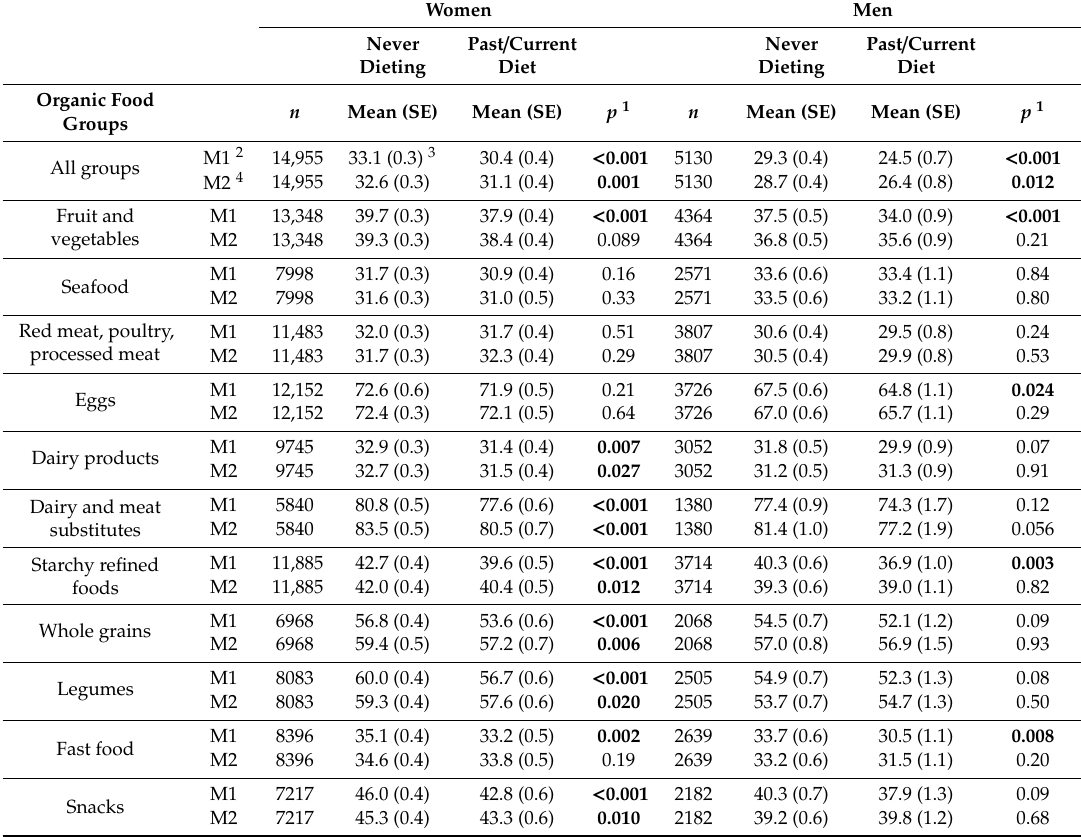
Table 4. Mean percentage of organic food intake out of total food intake, according to sex and